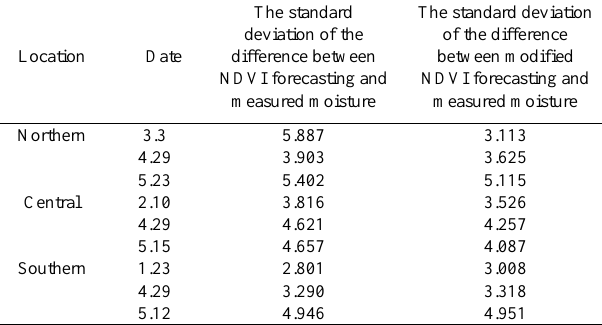
Table 11. Accuracy analysis of 20cm soil moisture